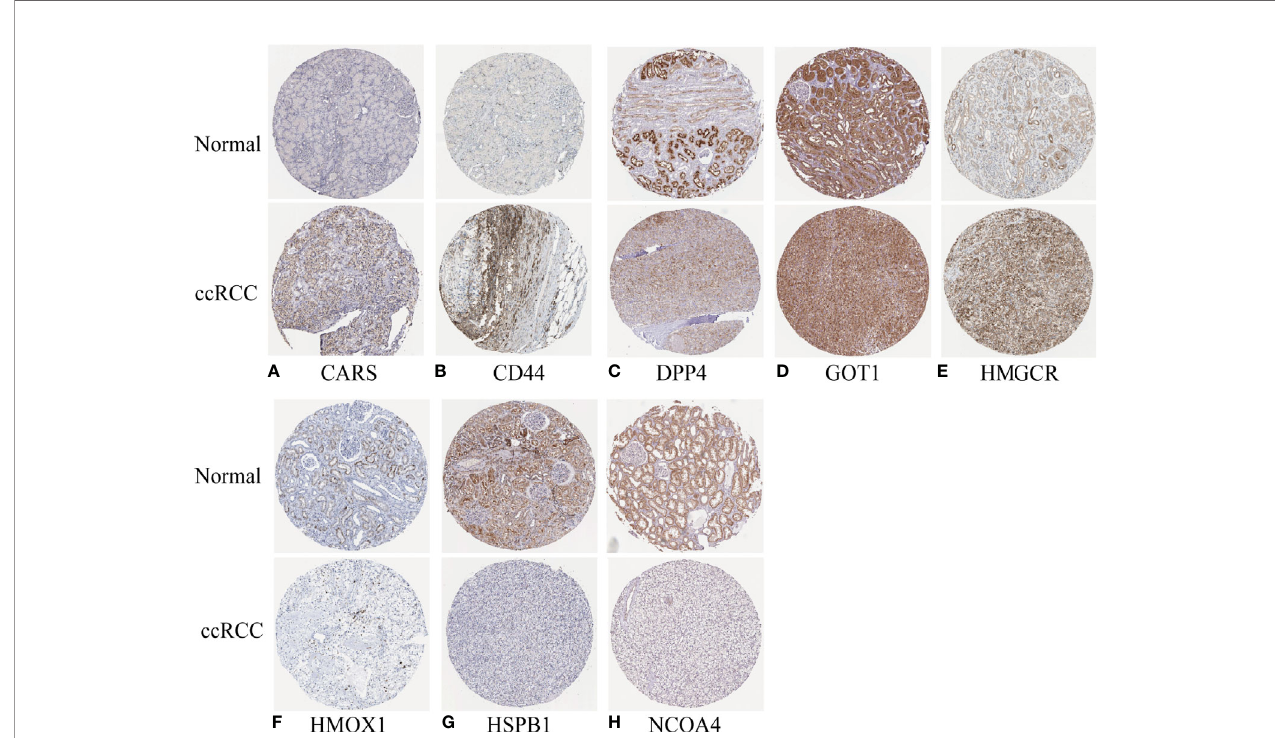
FIGURE 7 | Verify the translational expression of ferroptosis-related in ccRCC and normal kidney tissues. (A) CARS, (B) CD44, (C) DPP4, (D) GOT1, (E) HMGCR, (F) HMOX1, (G) HSPB1, (H)